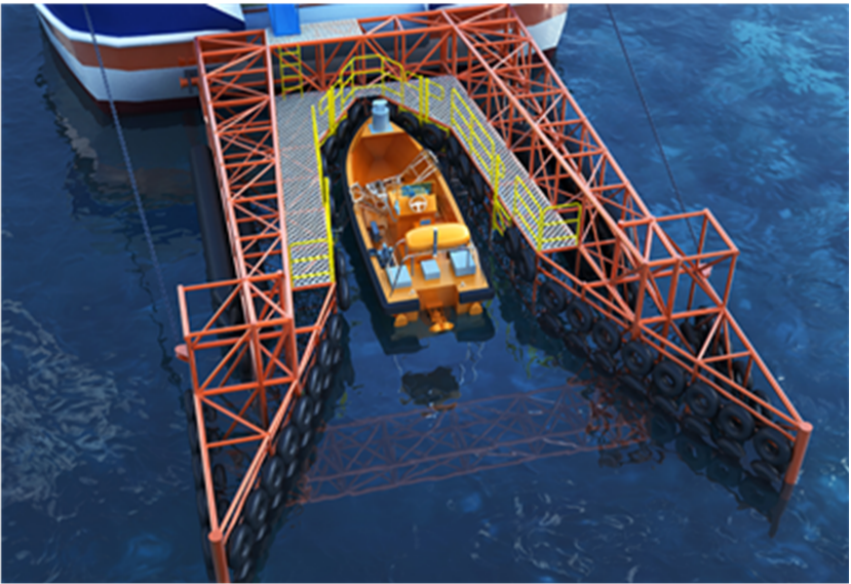
Figure 1. Mechanical structure of the USV and